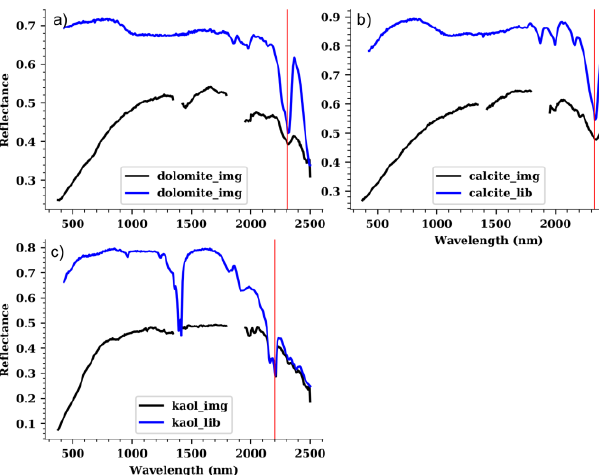
Figure 4. Inter-comparison of reflectance spectra of library and image for dolomite (a), calcite (b) and kaolinite (c). Red lines are placed at 2.31, 2.33 and 2.20 µm in figure a, b and c. The image spectra were collected from locations marked as S1, S2 and S3 in figure-3